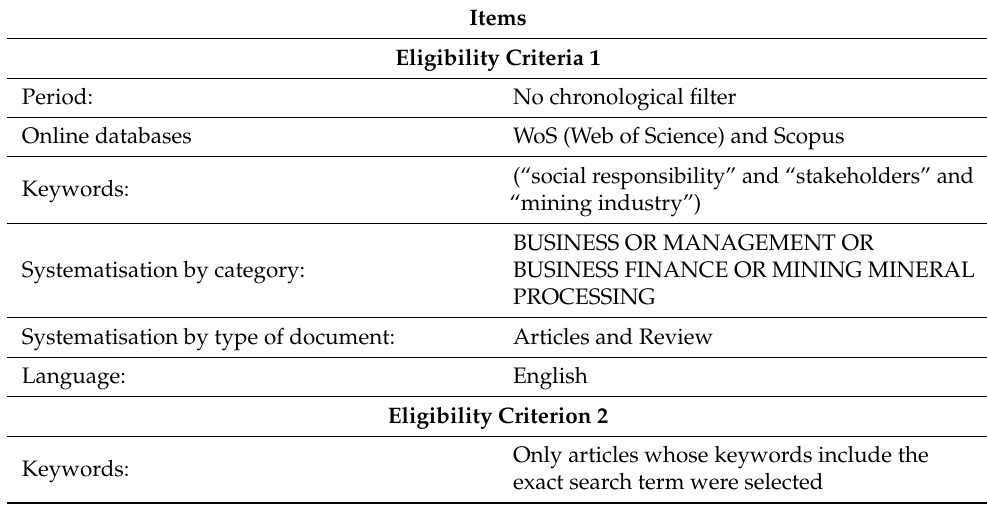
Table 1. List of eligibility criteria.